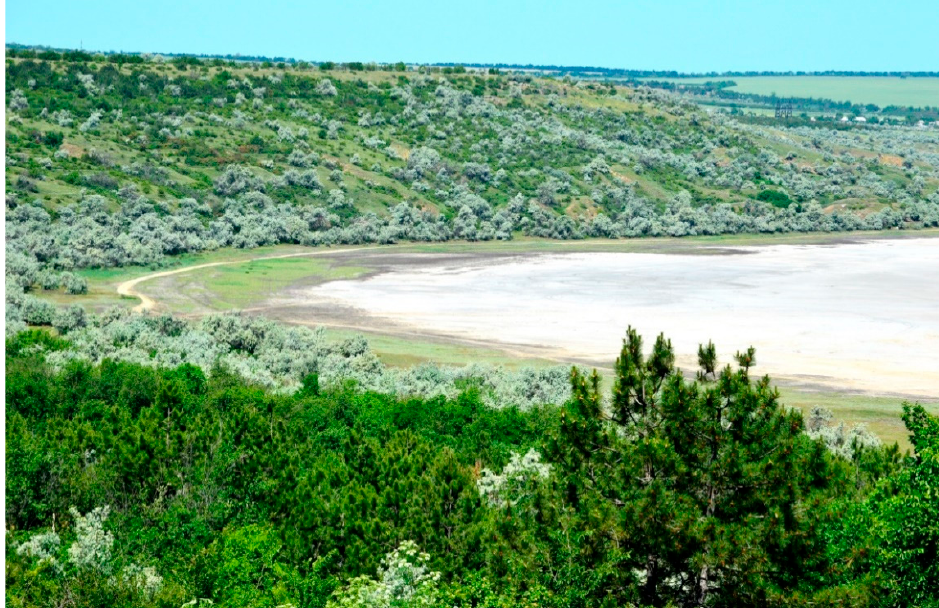
Figure 3. The right bank and the terraced slope of Kuyalnik Estuary (surroundings of Kovalivka village).